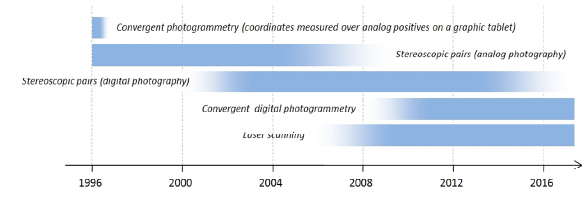
Figure 1. Timeline showing the use of different techniques for 3D documentation based on photographs and laser scanning by the Laboratory for Geometric Documentation of Heritage of the University of the Basque Country from 1996 until now. Film negatives refer to the second line: “stereoscopic pairs (analog photography)”.